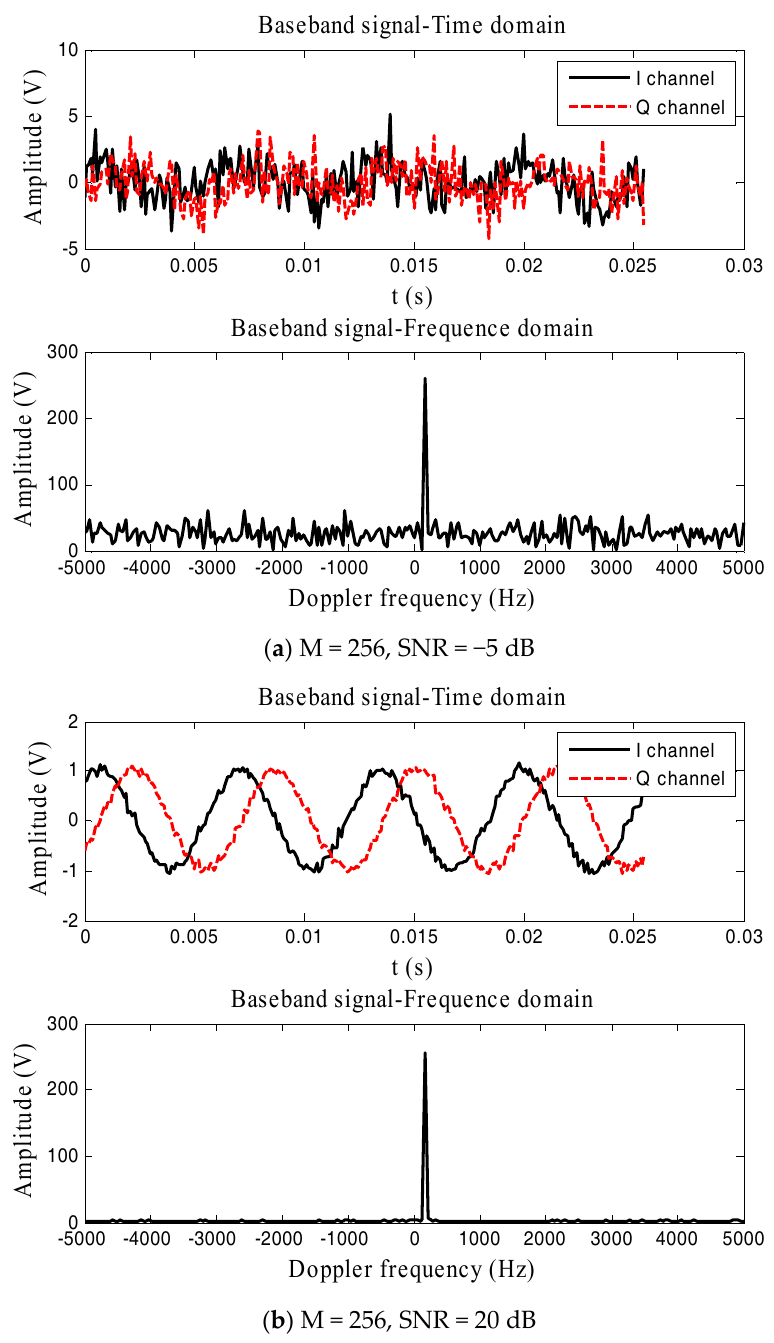
Figure 2. Baseband data in time domain and frequency domain.